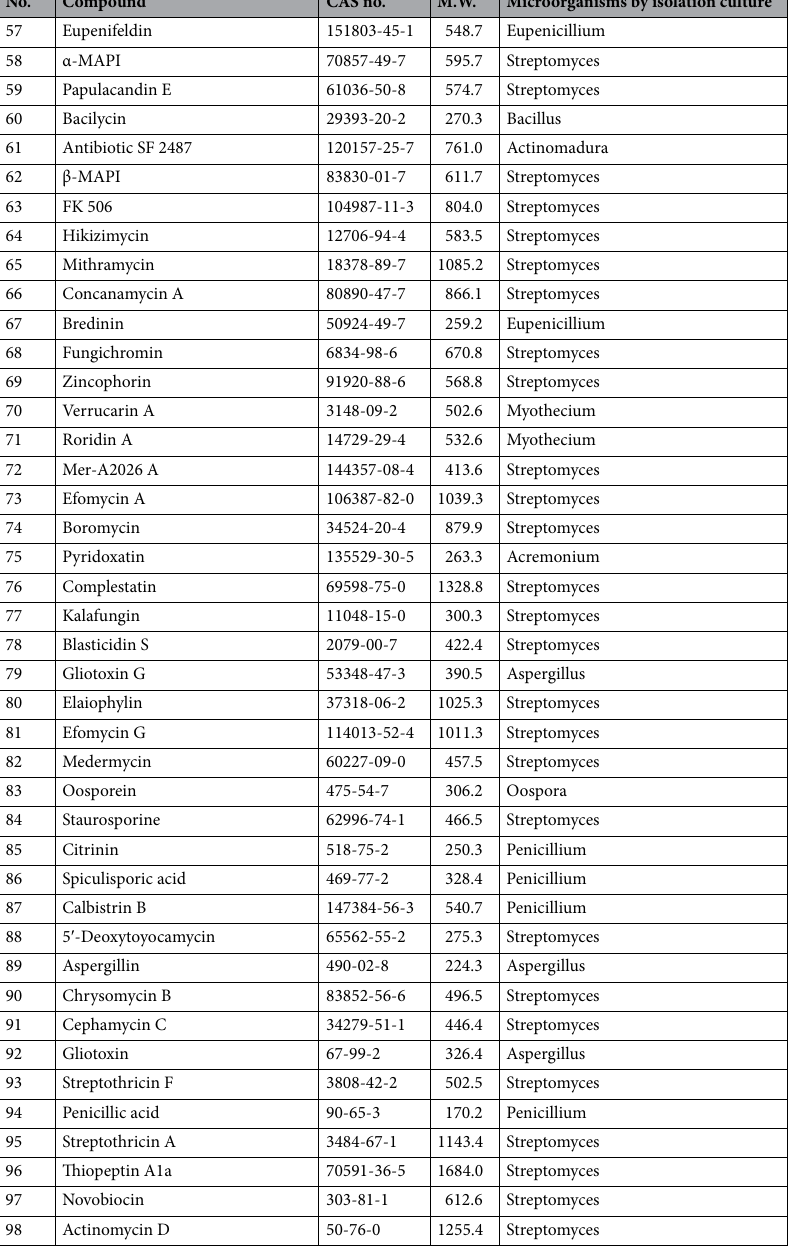
Table 1. List of secondary metabolites from soil